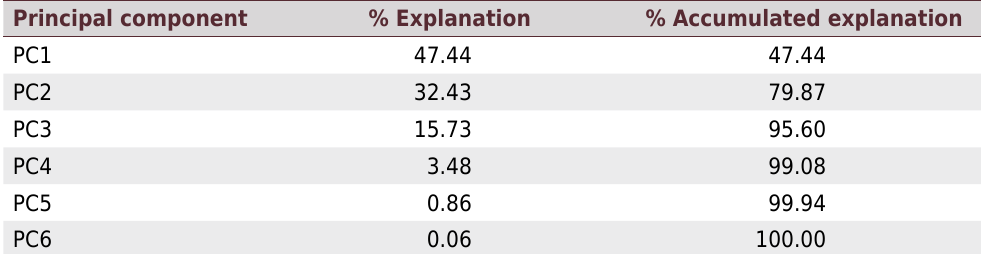
Table 1. Percentages of the sum of total squares (methods × months) associated with each main axis, being the individual and accumulated values according to AMMI analysis for the standard method (WS) and the other methods (MF, MF-Z, MF-M, RD, TRMM-F and TRMM-M) use to estimate the rainfall erosivity of Pirassununga-SP